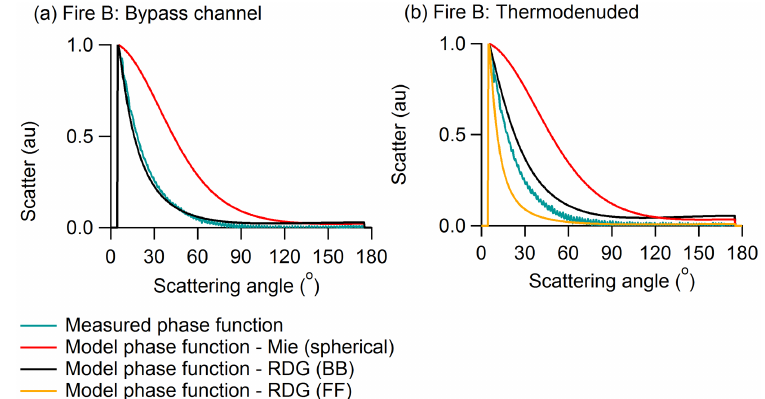
Figure 8. Comparison of measured (blue) phase function at 405nm to Mie theory model (red) and RDG models (black and orange) for one cycle of sampling through bypass channel (a) and after the thermodenuder (b) for Fire B. Two RDG parameterizations were compared: fossil fuel (FF; orange) and biomass burning (BB; black). Phase functions are normalized to unity at 5 ◦ scattering angle. Mie theory calculations are based on HULIS refractive index (Dinar et al., 2008) and RDG calculations are based on sage fuel for biomass burning (BB) case (Chakrabarty et al., 2006) and laboratory combustion of fossil fuels (FF; Sorensen,